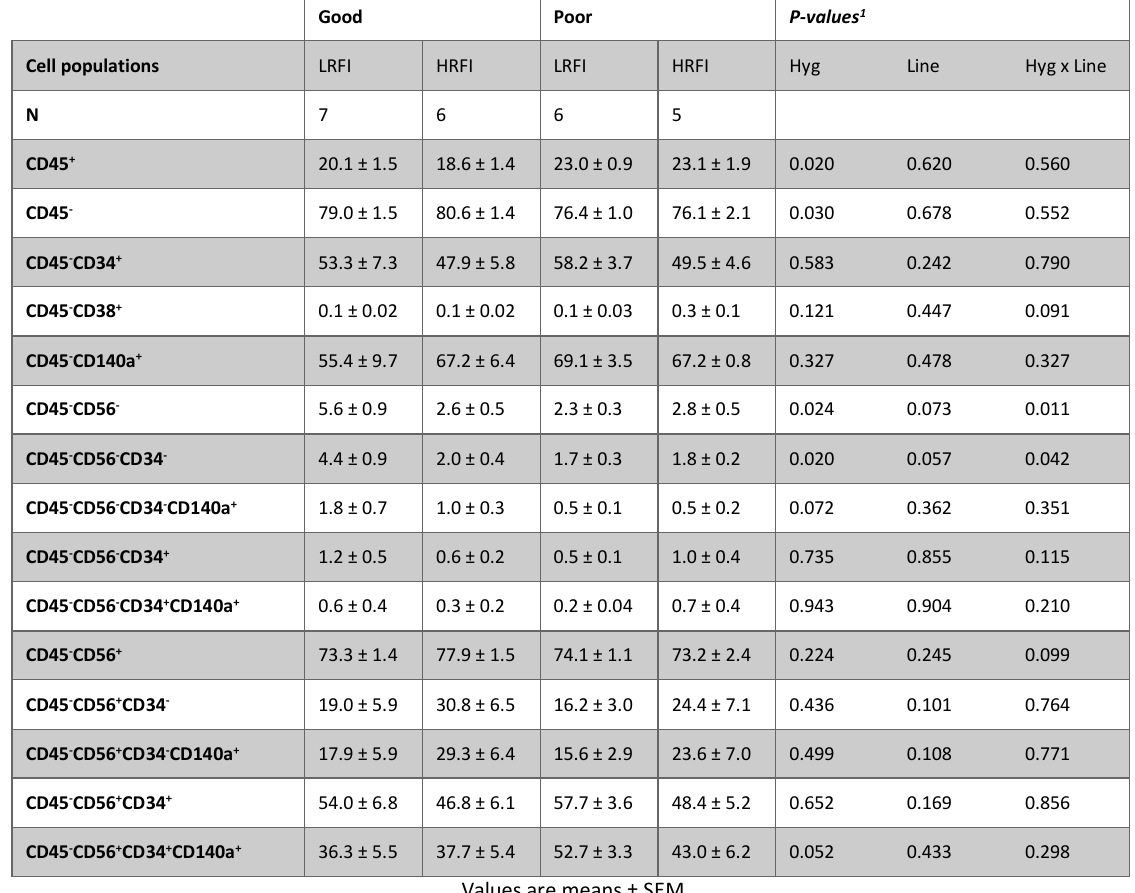
Table 4. Percentage of cell populations in longissimus muscle of low (LRFI) and high (HRFI) residual feed intake pigs housed in good or poor hygiene conditions for six weeks